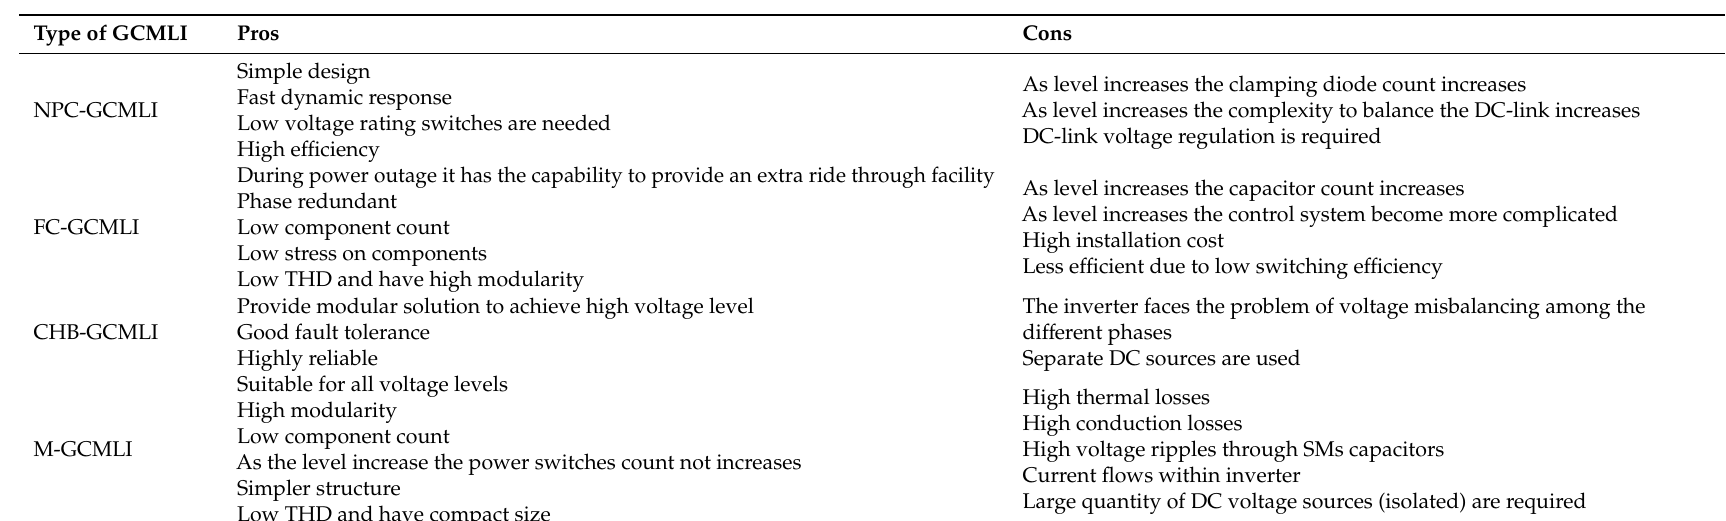
Table 3. Advantages and disadvantages of